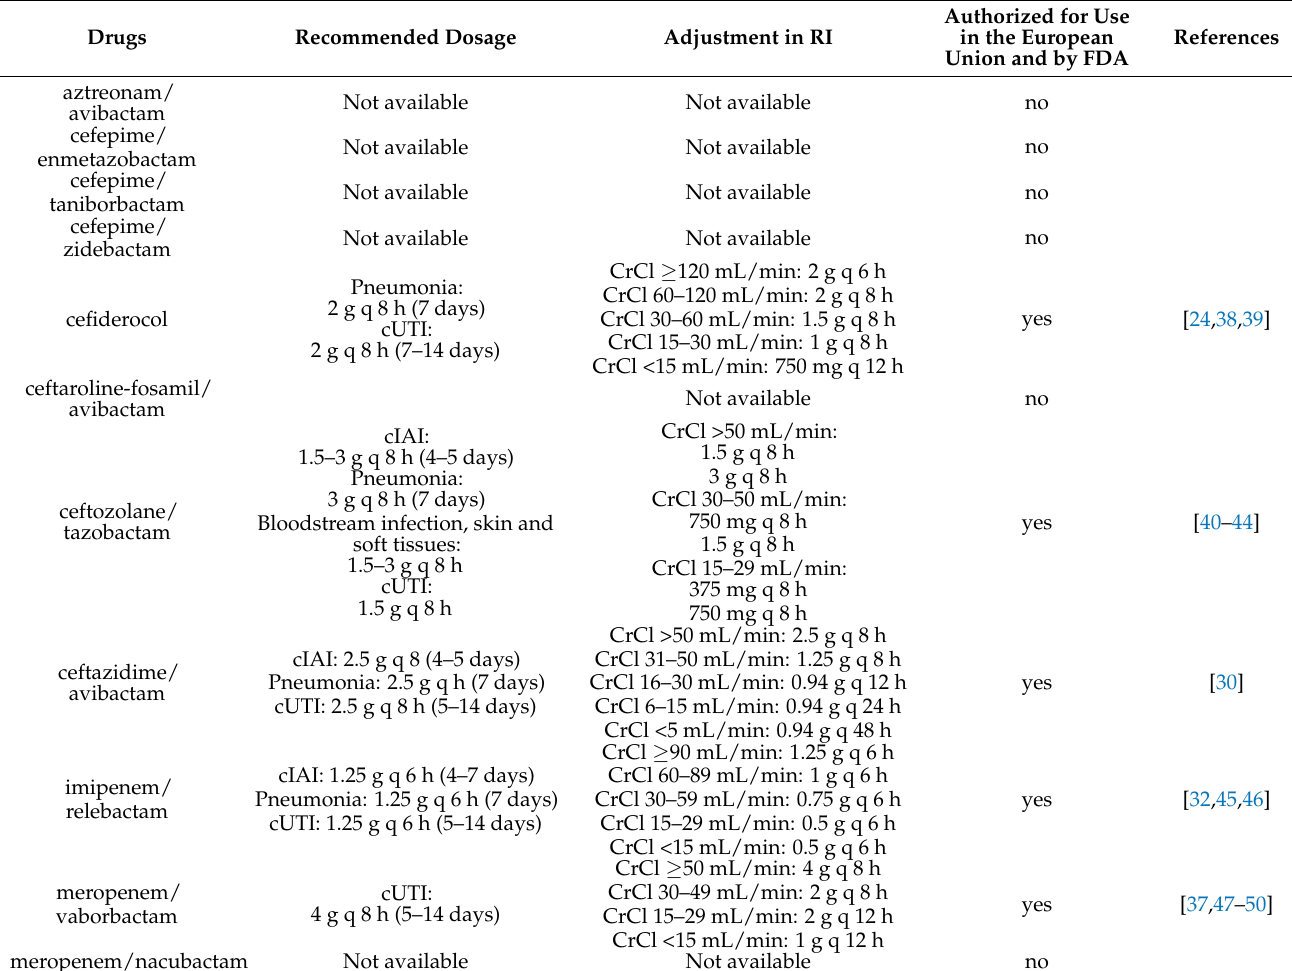
Table 4. Recommended dosages and dose adjustment in renal